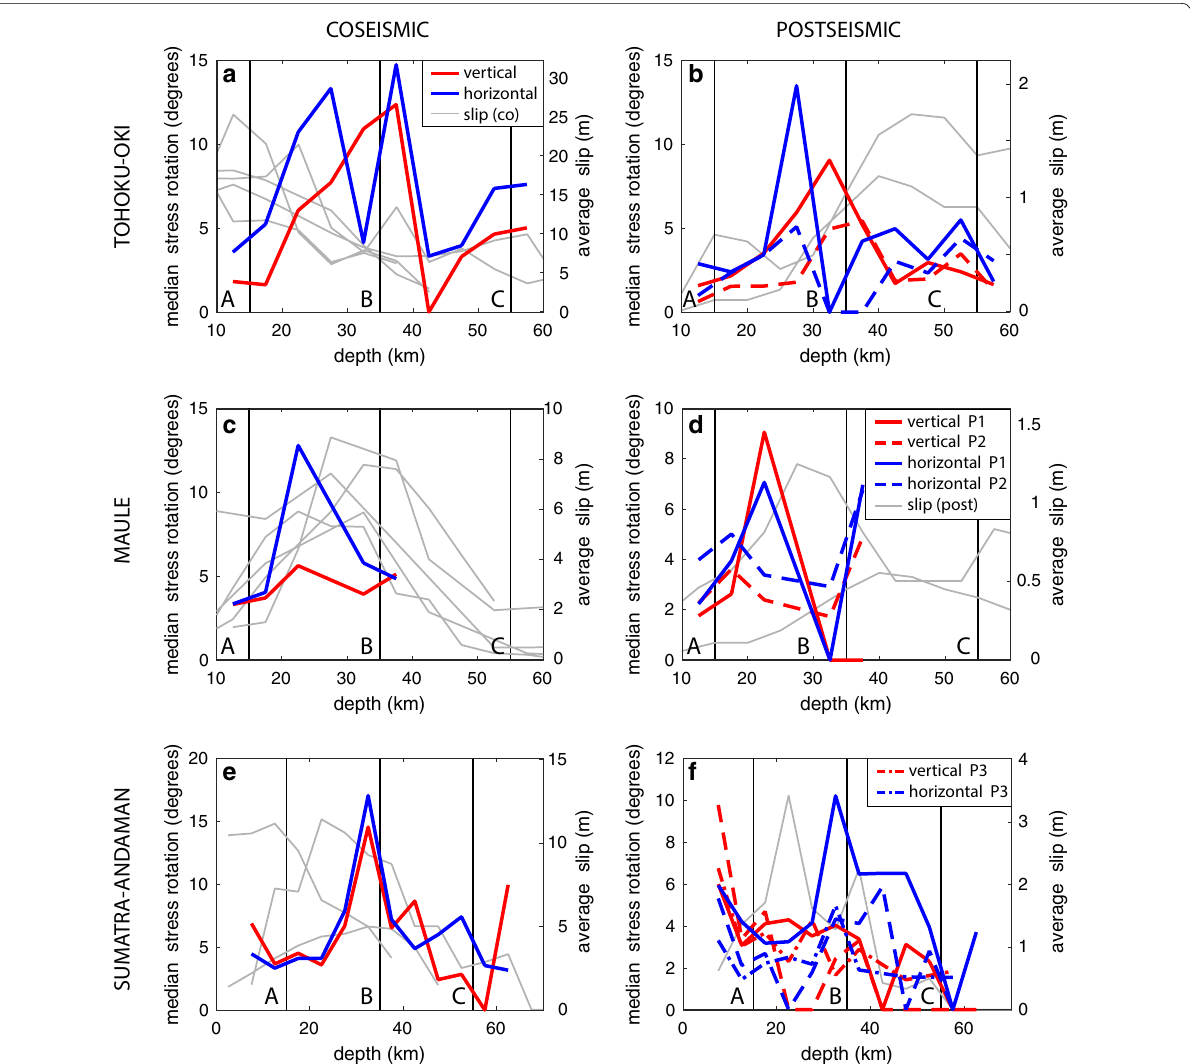
Fig. 4 Stress rotation as a function of subduction interface depth. The median vertical ( red ) and horizontal ( blue ) stress rotations are found for all inversion bins in 5-km depth intervals. Multiple realizations are performed by sampling a rotation for each bin from its bootstrap uncertainty, and the median is set to zero if it is not significantly different from zero at 1-sigma uncertainty. Vertical black lines and letters separate zones A , B , and C , as defined by Lay et al. (2012). a Tohoku-Oki earthquake coseismic stress rotation. Gray curves indicate average mainshock slip as a function of depth from slip models of Shao et al. (2011), Ide et al. (2011), Yagi and Fukahata (2011), Yamazaki et al. (2011) and Minson et al. (2014). b Tohoku-Oki earthquake postseismic stress rotation, P1 shown as solid lines and P2 as dashed lines . Gray curves indicate average afterslip as a function of depth from models of Ozawa et al. (2011) and Yamagiwa et al. (2015). c Maule earthquake coseismic stress rotation. Gray curves indicate mainshock slip models of Delouis et al. (2010), Lorito et al. (2011), Moreno et al. (2012), Pollitz et al. (2011) and Yue et al. (2014). d Maule earthquake postseismic stress rotation, P1 shown as solid lines and P2 as dashed lines . Gray curves indicate afterslip models of Bedford et al. (2013) and Lin et al. (2013). e Sumatra–Andaman earthquake coseismic stress rotation. Gray curves indicate mainshock slip models of Ammon et al. (2005), Rhie et al. (2007) and Chlieh et al. (2007), f Sumatra–Andaman earthquake postseismic stress rotation, P1 shown as solid lines , P2 as dashed lines , and P3 as dash-dot lines . Gray curve indicates afterslip model of Chlieh et al. (2007), black curve the 2005 M8.6 Nias–Simeulue earthquake slip model of Ji